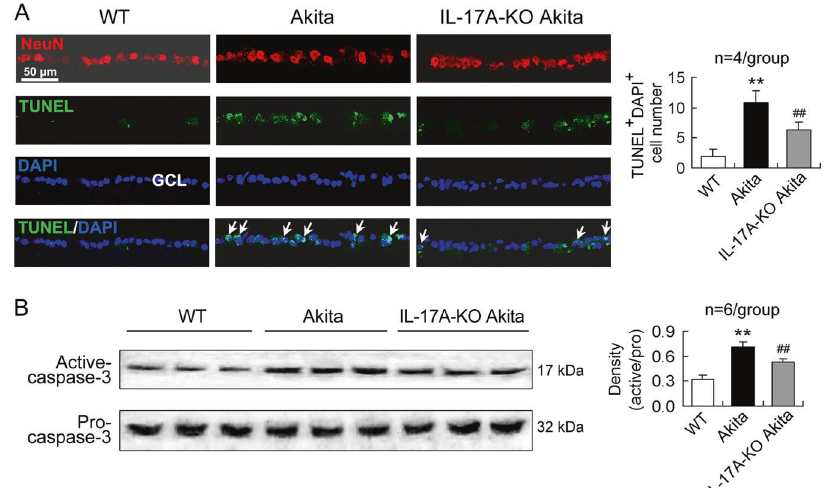
Fig. 3 IL-17A-de fi cient diabetic mice show a decreased RGC apoptosis. The design of the mice was similar to that in Fig. 1. A Neuronal apoptosis in the GCL of the retina determined by TUNEL assay. The cells labeled by NeuN in the GCL indicate neurons. The TUNEL/DAPI double positive cells in the GCL represent apoptotic RGCs. The arrows indicate typical apoptotic RGCs. In the statistical histogram, TUNEL + DAPI + cell number was obtained by averaging the number of three sections of one retina. The experiment was repeated four times. B Retinal caspase-3 activity analyzed by western blot. The statistical data were representative of six mice for each group. ** P < 0.01, versus WT mice; ## P < 0.01, versus Akita